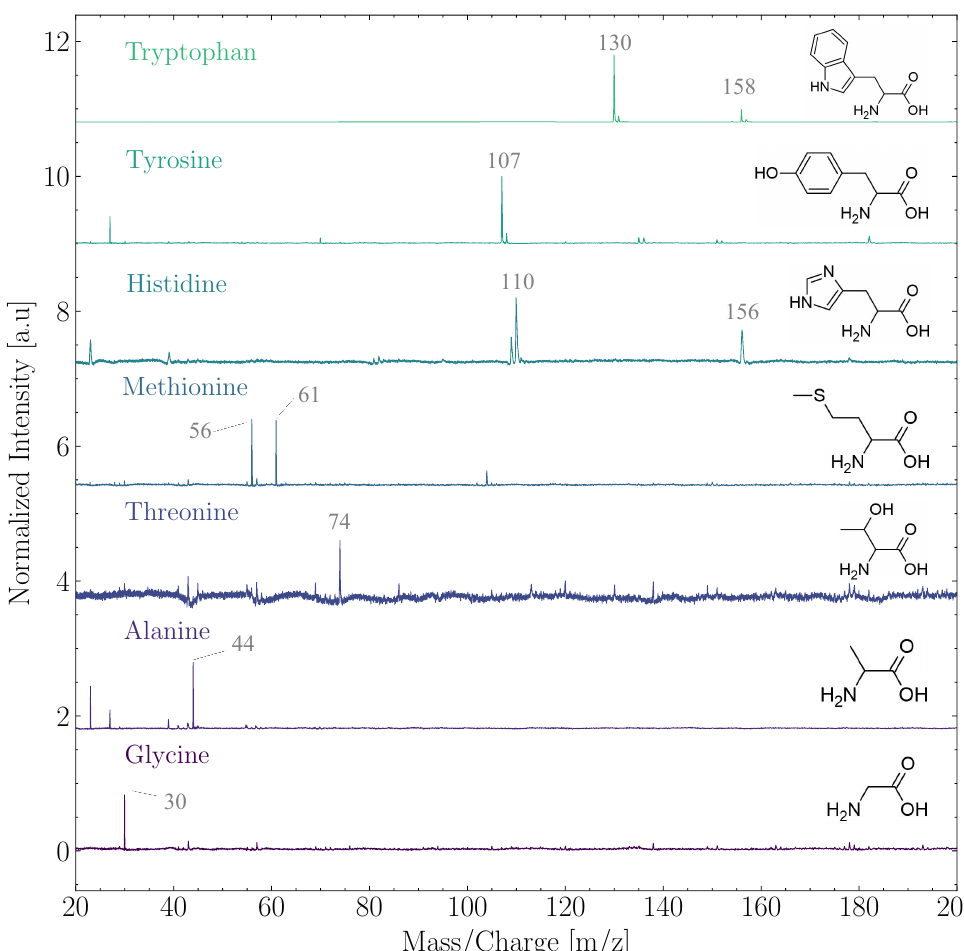
Figure 1. Normalized spectra of the amino acids tryptophan, tyrosine, histidine, methionine, threo- nine, alanine, and glycine. The structure of the respective amino acid has been added to the right and prominent mass peaks are indicated. The spectra have been offset from each other. All mea- surements were conducted at pulse energies between 2 and 3 µ J at an average surface coverage of 14.1 pmol mm − 2